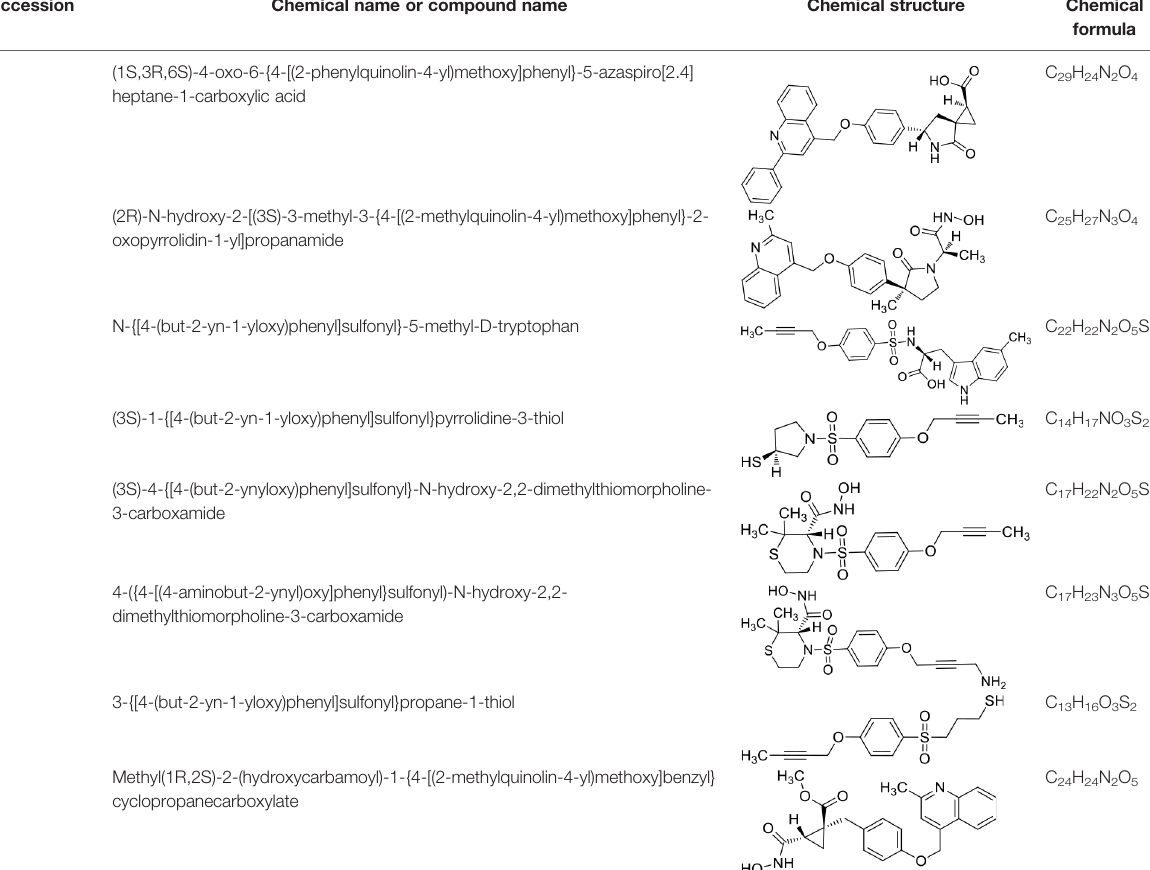
TABLE 2 | Representative small molecule compounds targeting ADAM17. DrugBank accession Chemical name or compound name Chemical number